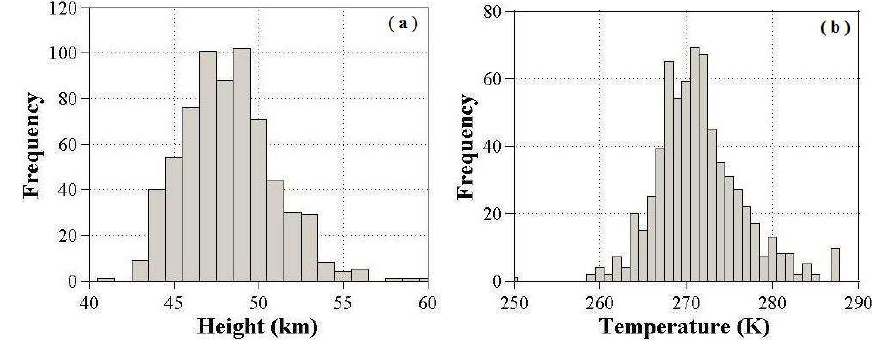
Fig. 3. Histograms showing frequency distribution of (a) stratopause heights and (b) stratopause Figure 3: Histograms showing frequency distribution of (a) Stratopause heights and (b) 13 Stratopause Temperatures. 14